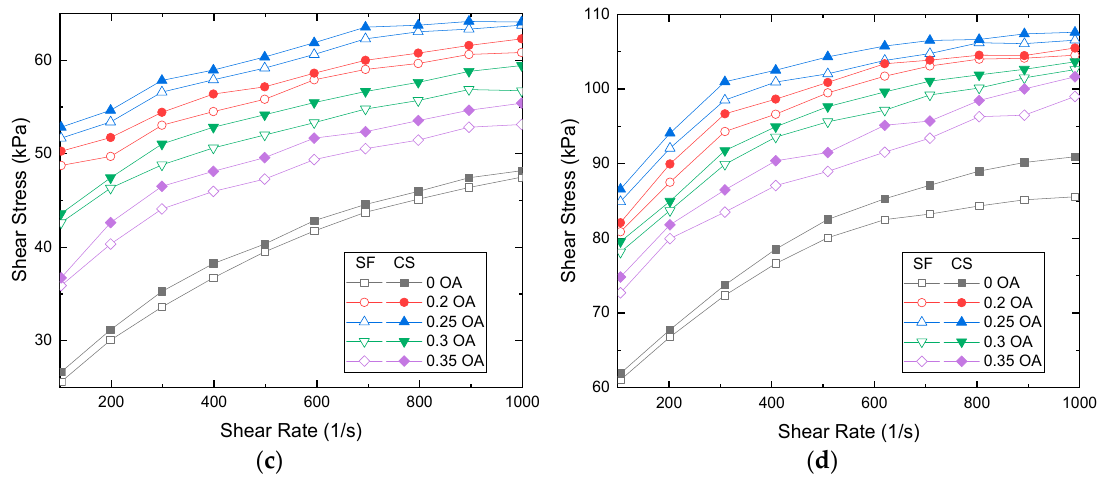
Figure 3. Shear stress vs. shear rate for MR fluids with a variable composition of oleic acid subjected to different magnetic fields. ( a ) 0 kA/m, ( b ) 45 kA/m, ( c ) 81 kA/m and ( d ) 136 kA/m.